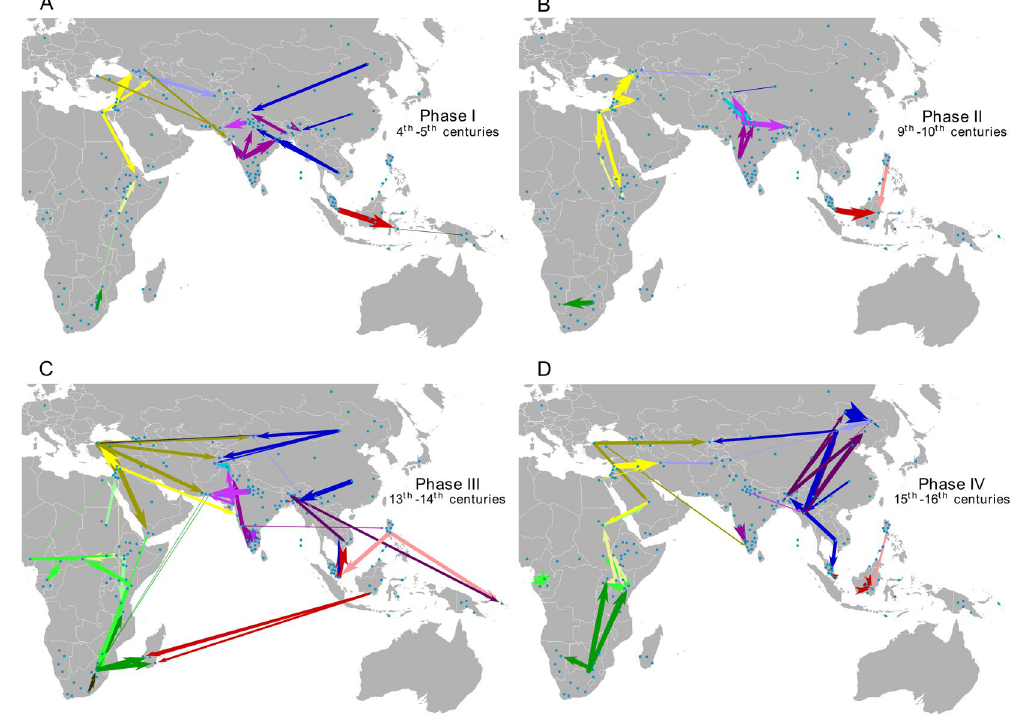
Figure 2. Maps showing gene flow during the four phases of Indian Ocean trade. Admixture events during two century periods are plotted for each phase: ( A ) Phase I, ( B ) Phase II, ( C ) Phase III and ( D ) the beginning of Phase IV. Arrow widths are proportional to the percentage of ancestry inherited from each source population. Colors are specific to each cluster, as defined by the fineSTRUCTURE 31 results: green palette: sub-Saharan African Pygmies, Bantu, East African and Malagasy clusters; yellow palette: Middle East, Nilo-Saharan and Caucasus clusters; purple palette: Pakistan, India and Bengal clusters; blue palette: East and North Asian clusters; red palette: Indonesian clusters; brown and orange palettes: Negrito, Andaman and Papuan clusters. Blue dots illustrate the locations of sampled populations. Maps were generated using Global Mapper v.15.